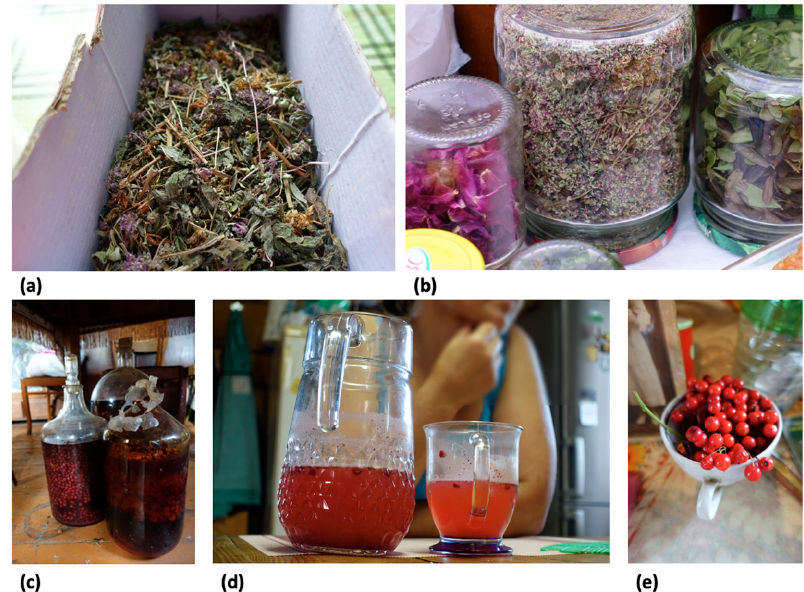
Figure 4. Wild species used for food: ( a ) mixed herbs dried for recreational tea, Lithuania; ( b ) herbs prepared for recreational tea, Poland; ( c ) wine made from Rubus idaeus , Belarus; ( d ) compote, made from Fragaria vesca , Lithuania; and ( e ) snack of Viburnum opulus , Belarus. Credit: J.P., 2018–2019.